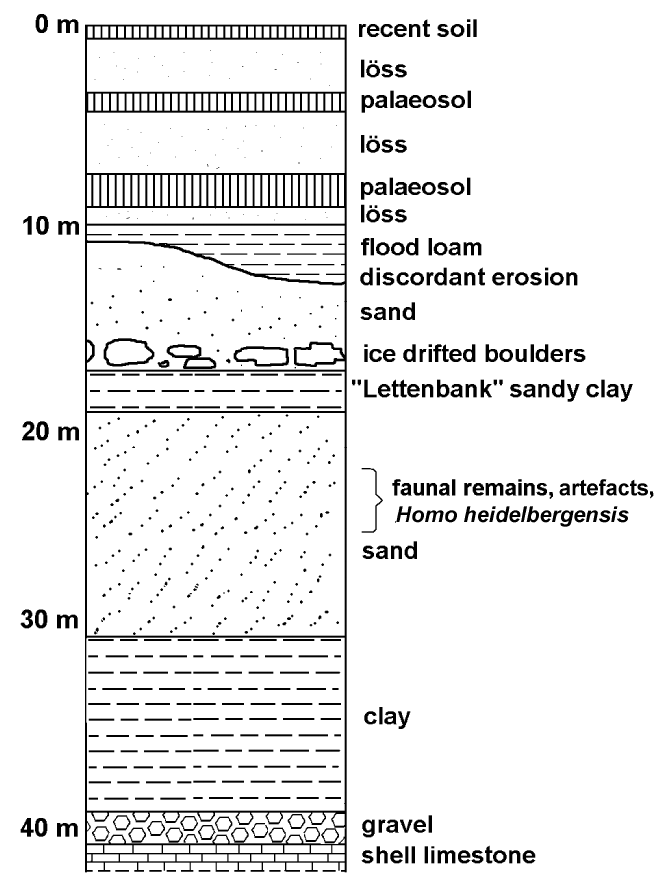
Figure 16. Mauer, “Grafenrain“ pit. (Redrawn after Zöller et al. 1997 in Wagner et al. 1997.).